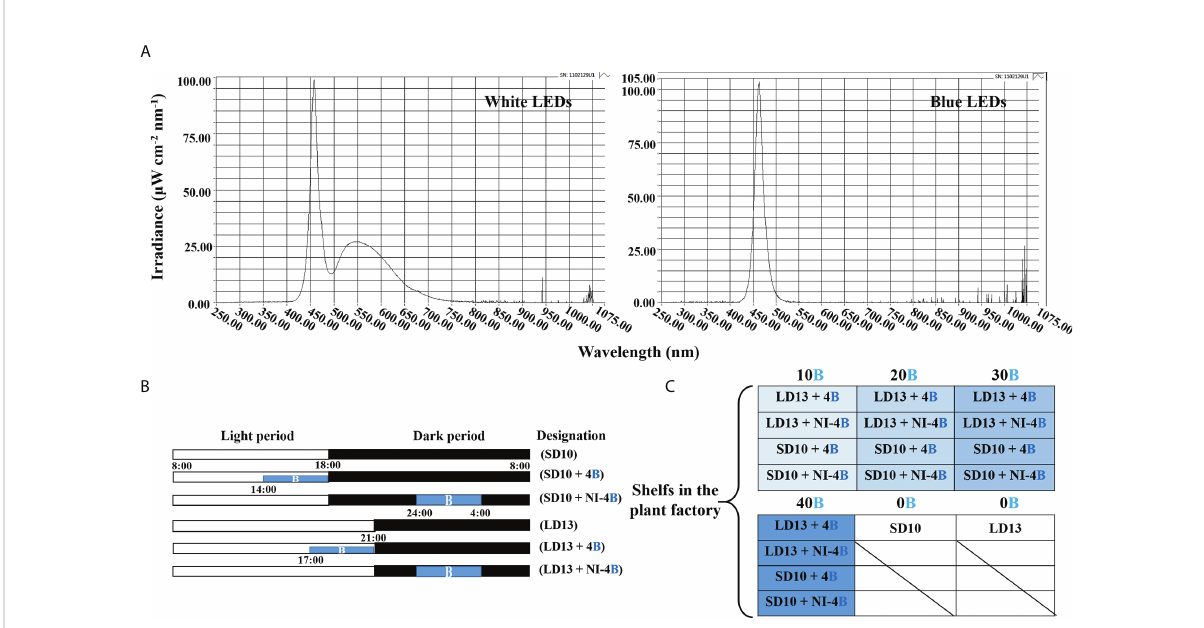
FIGURE 1 The light spectral distribution of experimental light treatments (A) : the daily white light (~400-720 nm, and peaked at 435 nm) provided by white LEDs and blue light (peaked at 450 nm) from blue LEDs used as the supplemental or night-interruptional light. The experimental light schemes employed in this study (B) : the light period started and the dark period ended at everyday 8:00 a.m.; plants in the control groups were with a 10-h short-day (SD10, positive control) or 13-h long-day (LD13, negative control) condition, without any blue light; the 4-h blue light with either